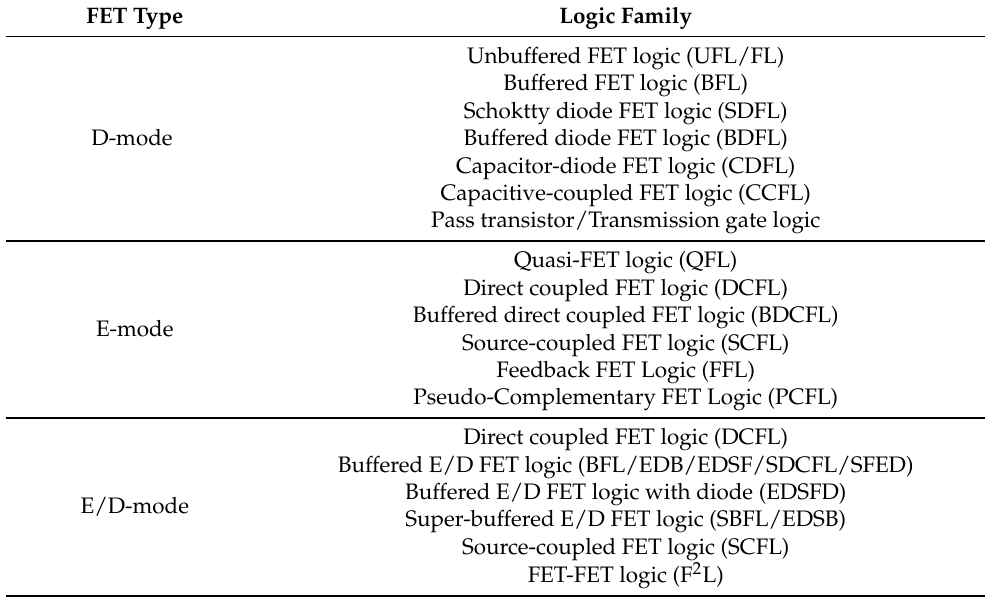
Table 2. GaAs FET logic gate